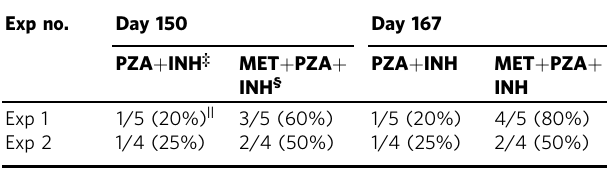
Table 1 Ef fi cacy of metformin against Mtb in modi fi